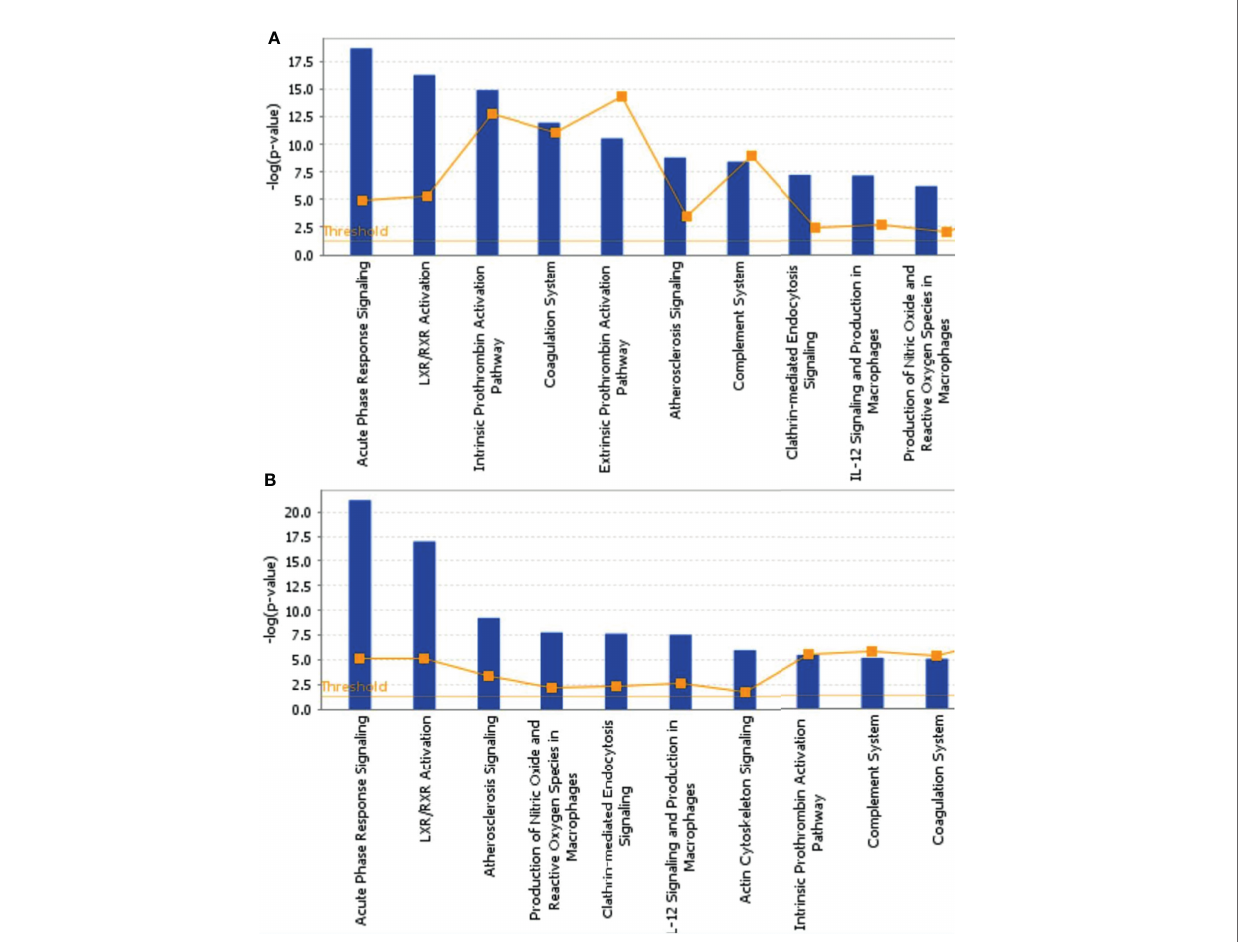
FIGURE 4 | Predominant canonical pathways based on differentially expressed proteins in B-NHL (A) and T-NHL (B) compared with the control. The cutoff of p value was set to